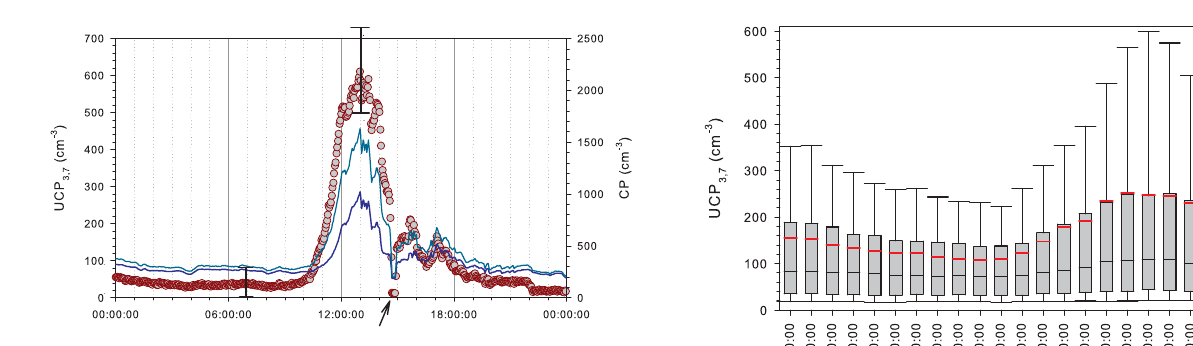
Fig. 8. UCP 3 , 7 concentrations observed at 12 February 2006 (cir- cles, left hand scale) derived from the CPC 3022A and UCPC 3025A instruments (green and blue line, respectively; right hand scale) in the highest available temporal resolution (150s). The two error bars visualize the typical uncertainty of the calculated UCP 3 , 7 concentrations (see main text). The arrow marks the moment when the diffusion screen was switch on for 15min.